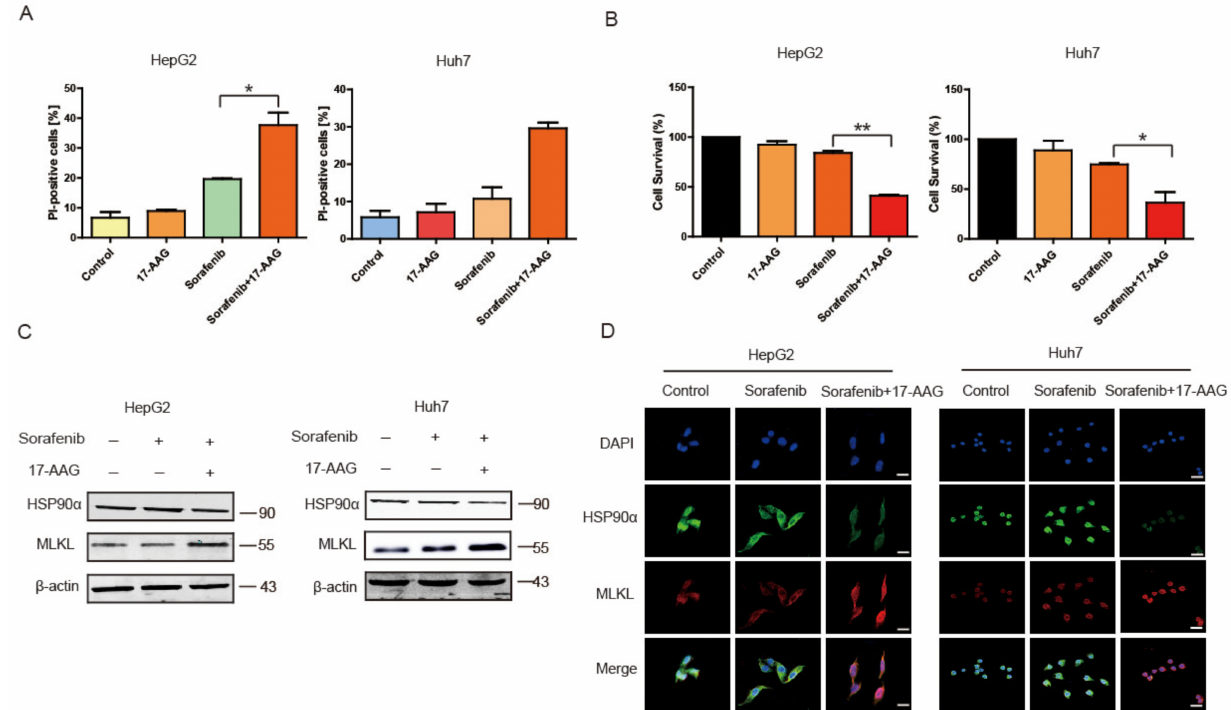
Figure 5. 17-AAG Combined with Sorafenib Treatment Enhanced Necroptosis Pathway in vitro. ( A ) Detection of death cells under hypoxia by Flow Cytometry. The results were shown as mean ± SEM from three independent experiments. * p < 0.05, ** p < 0.01. ( B ) The survival of liver cancer cells under hypoxia assessed by the MTT assay. The results were shown as mean ± SEM from three independent experiments. * p < 0.05, ** p < 0.01. ( C , D ) The detection of HSP90 α and MLKL by Western blot and Immunofluorescence. Scale bar = 40 µ